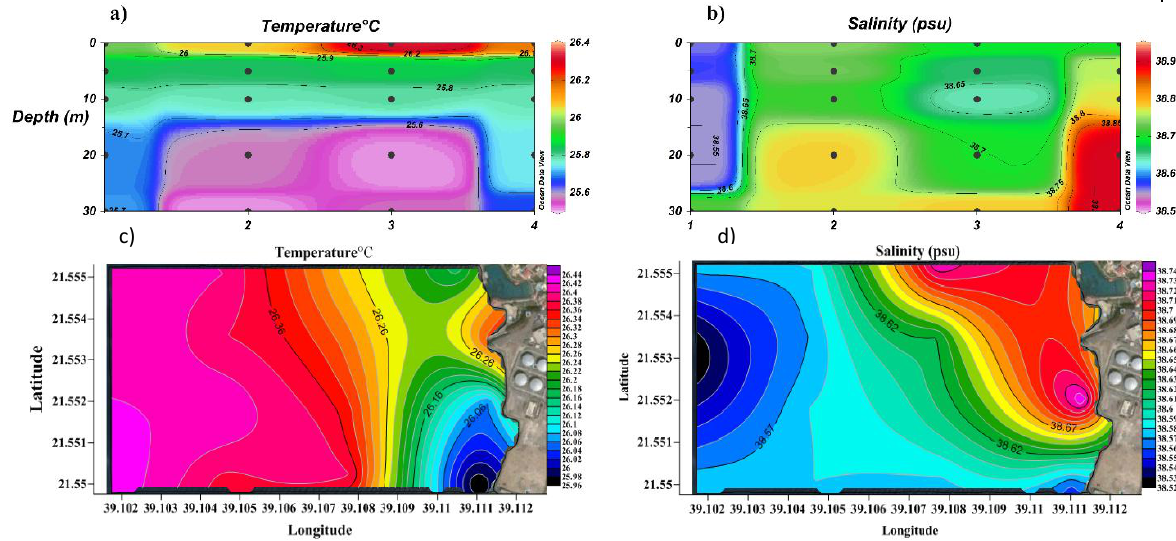
Figure 2: Cross-section profile of a) temperature and b) salinity; surface distribution pattern of c) temperature and d)